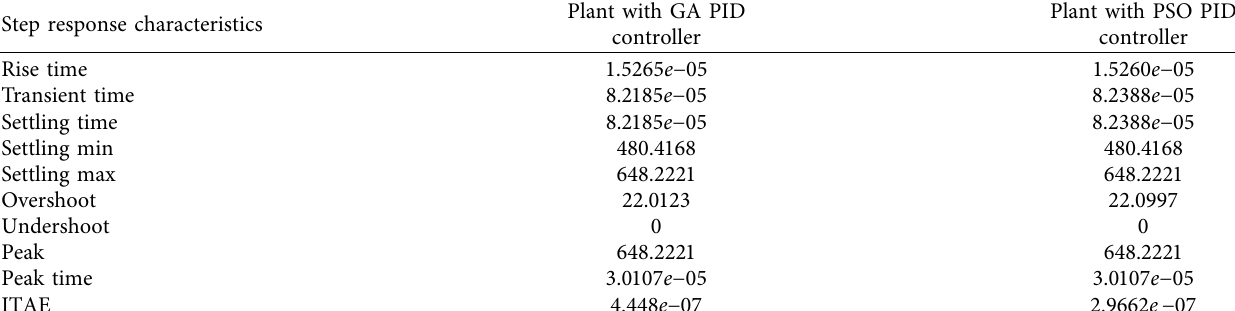
Table 1: Step response performance of the GA and the PSO PID controller.